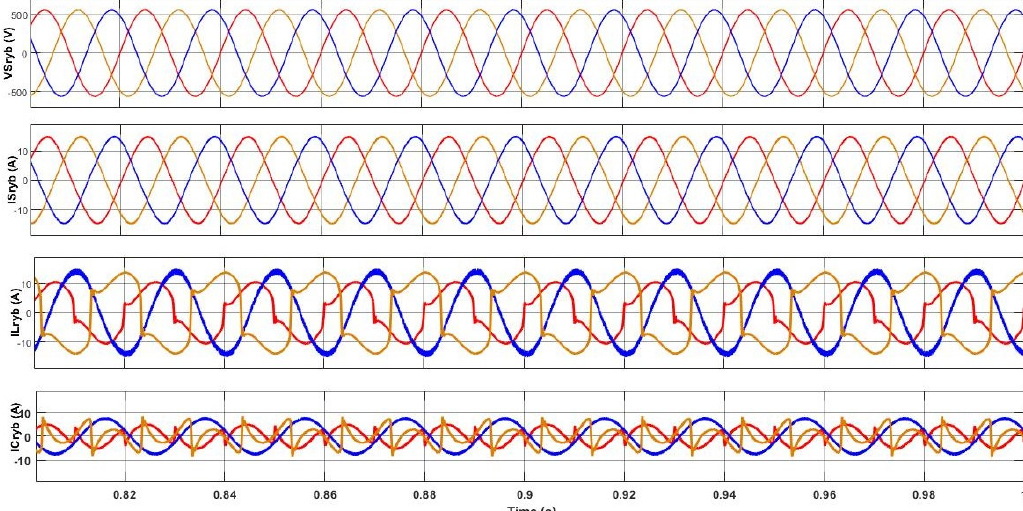
Figure 8. VSryb: input voltages, ISryb: input currents, ILryb: load currents, and ICryb: compensating currents.